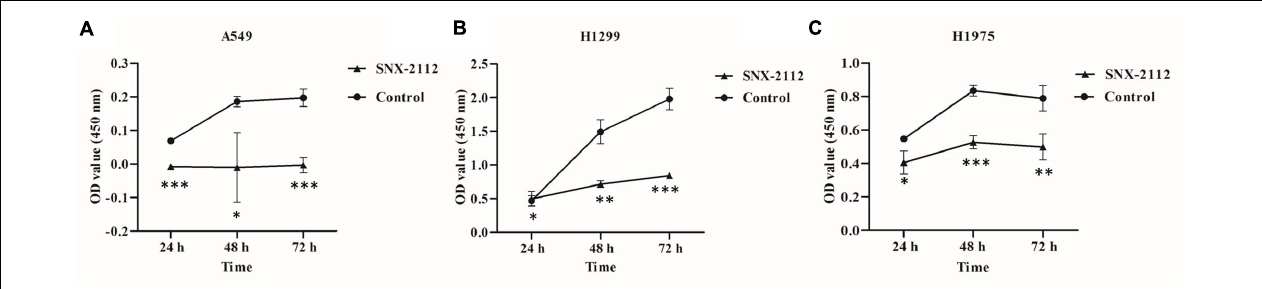
FIGURE 1 | SNX-2112 inhibited NSCLC cell proliferation. (A) A549 cells, (B) H1299 cells, and (C) H1975 cells. CCK-8 assay was performed to detect cell viability after treatment with SNX-2112 or DMSO for 24, 48, and 72 h. * p < 0.05, ** p < 0.01, and *** p < 0.001 indicate significant differences vs. control. SNX-2112 significantly suppressed cell viability against A549, H1299, and H1975 cells, and the inhibition activity increased with treatment time extension. Annotations: Control, cells treated with DMSO; SNX-2112, cells treated with SNX-2112.